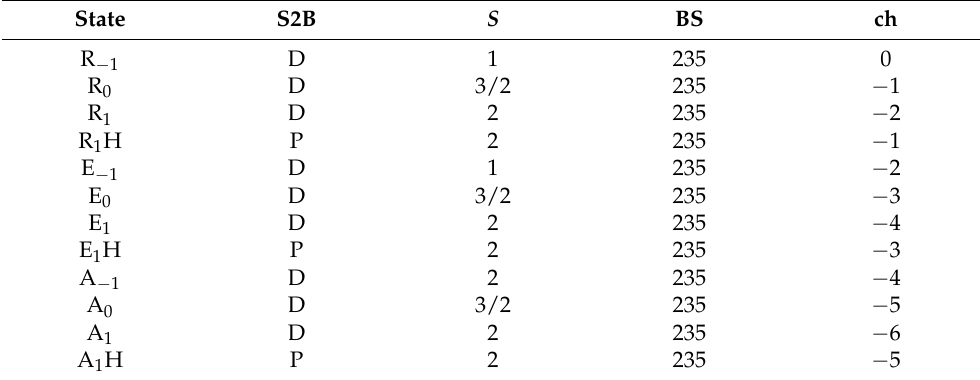
Table 3. States studied for the resting, one-electron reduced or one-electron oxidised states of the FeMo cluster. The table lists the protonation status of the S2B atom (P = protonated, D = deprotonated), the spin state ( S ), the BS state (specifying Fe ions with minority spin), and the net charge of the QM systems (ch; same for both for QM/MM and for the redox